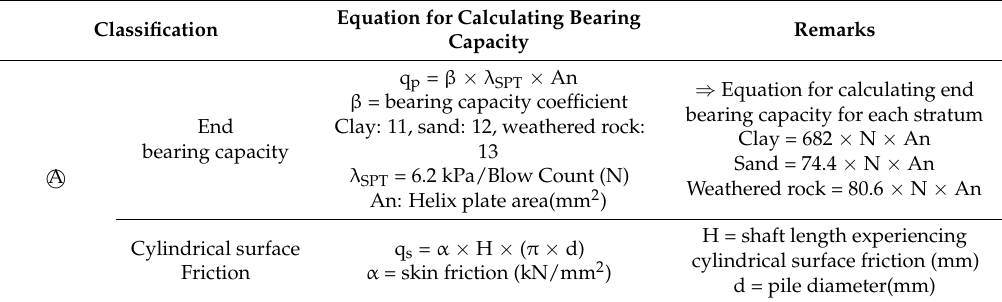
Table 7. Perko’s (2009) equation for calculating bearing capacity.